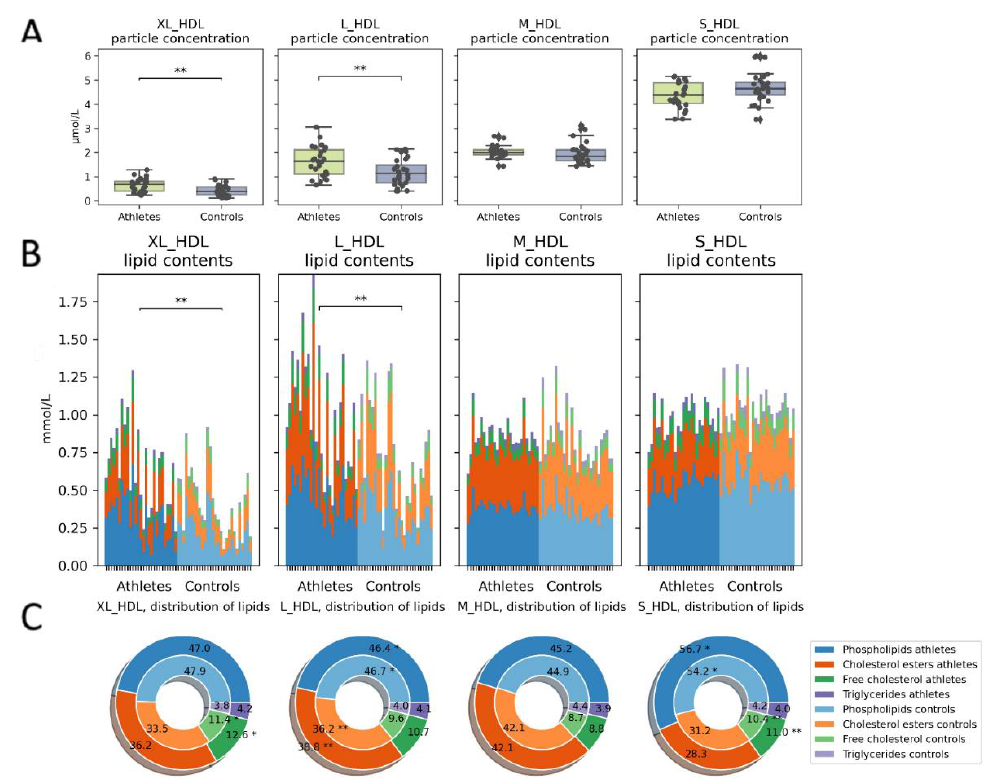
Figure 6. HDL particle concentrations and contents. ( A ) Total particle concentrations and ( B ) absolute lipid concentrations in the particles. Athletes had more large to very large HDL particles and consequently more lipids contained within them. ( C ) Relative proportions of lipids: the outer donut chart represents the athletes, and the inner represents controls. The athletes had a smaller phospho- lipid/cholesterol ratio in the large particles than the controls did. Kruskal–Wallis p value: * < 0.05, ** <